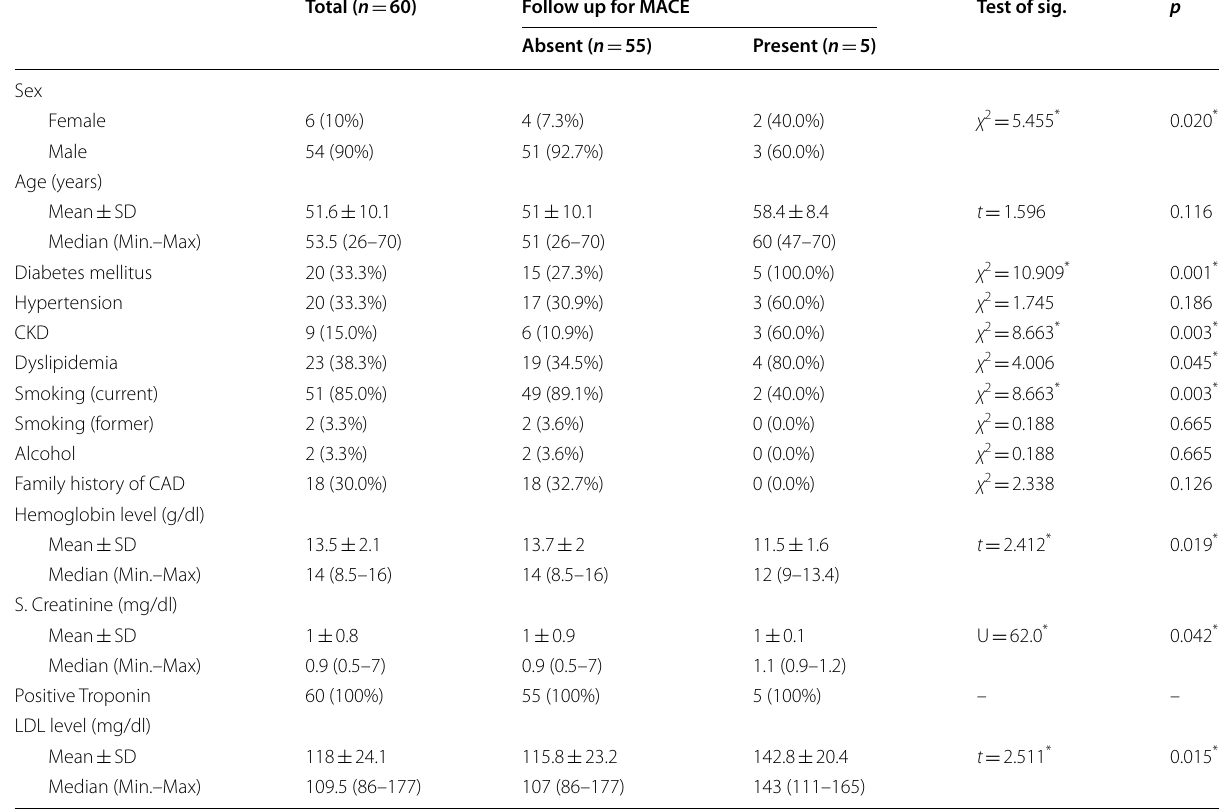
SD , Standard deviation; t , Student t -test; U , Mann Whitney test; χ 2 , Chi square test; p , p value for comparing between the studied